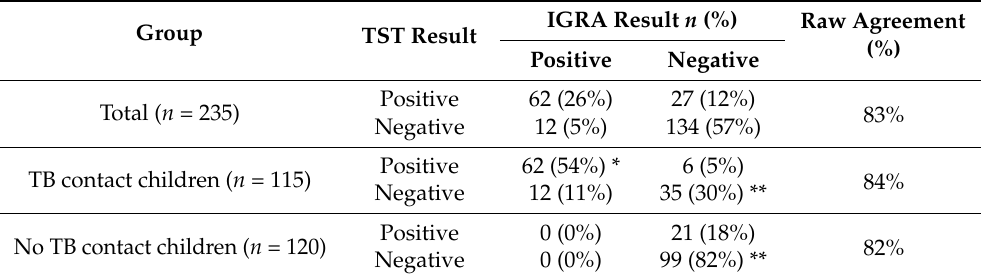
Table 5. Combination of the tuberculin skin test (TST) and interferon-gamma release assay (IGRA)